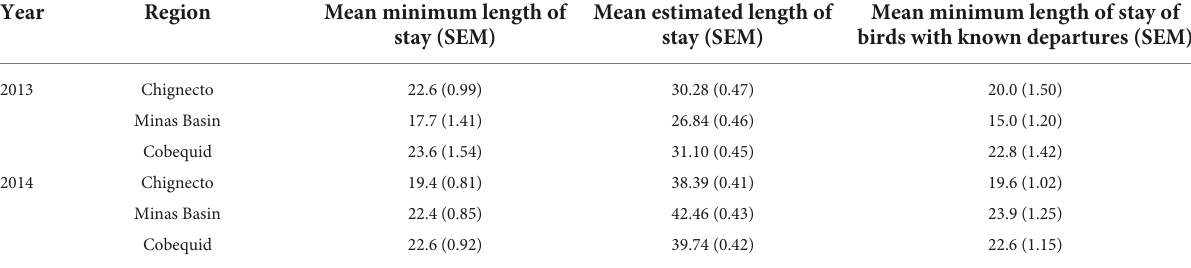
TABLE 1 Mean length of stay (days) controlling for date of capture and relative fuel loads at capture of tagged sandpipers for each region of the Bay of Fundy in 2013 and 2014. Mean minimum length of Mean estimated length of Mean minimum length of stay of stay (SEM) stay (SEM) birds with known departures (SEM)